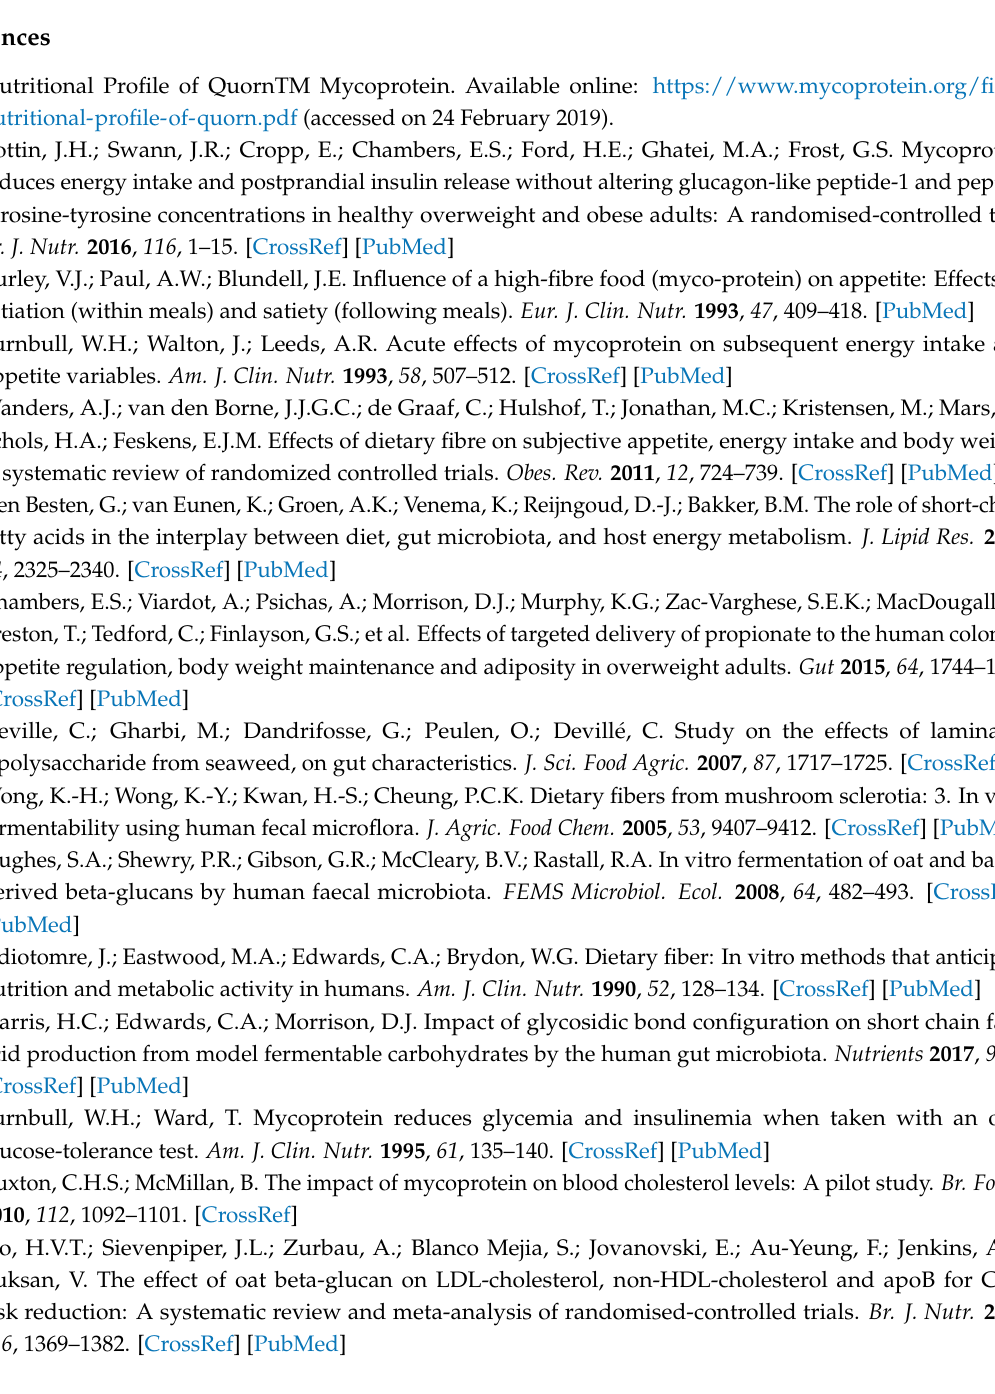
Table S1: Production of SCFA after 24 h batch